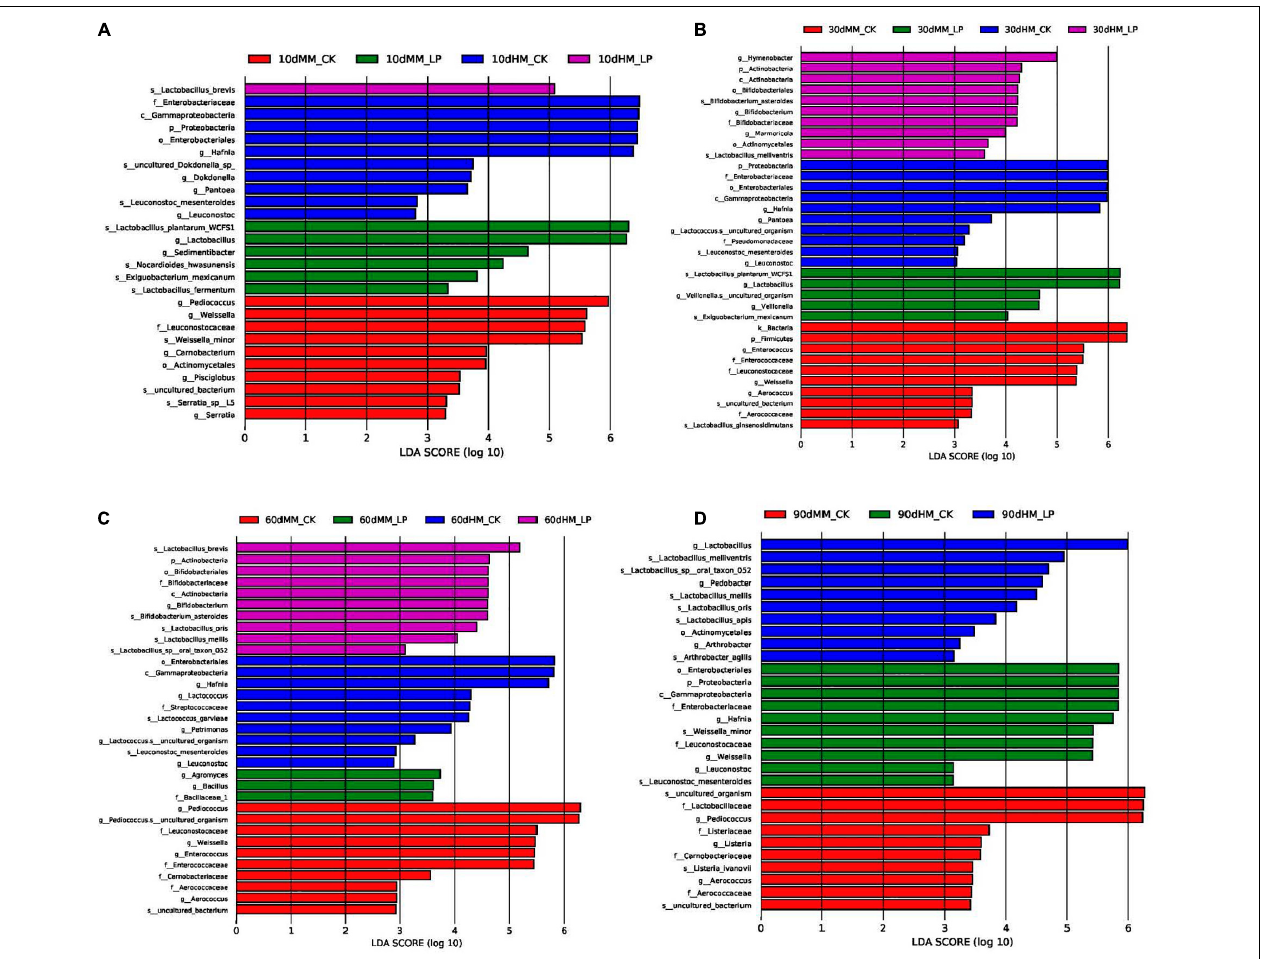
FIGURE 6 | Comparison of microbial variations at 10 (A) , 30 (B) , 60 (C) , and 90 (D) days using LEfSe analysis. HM, not wilted before ensiling; MM, wilted before ensiling; CK, silage without inoculation; LP, silage inoculated with L. plantarum